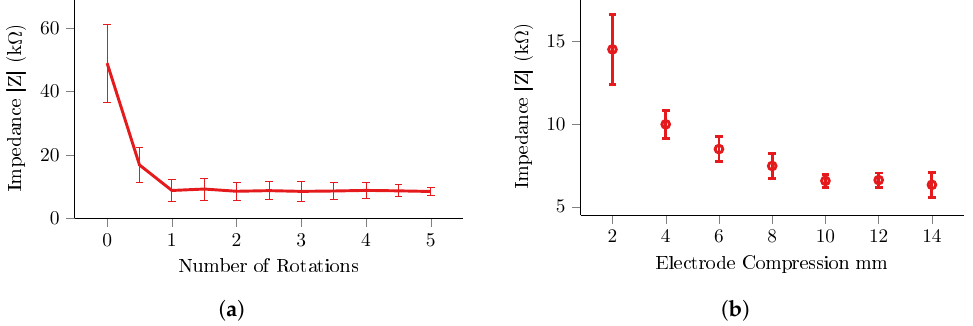
Figure 15. 32 Channel Electrode Helmet ( a ) abrasion results for all electrodes ( b ) minimum impedance achieved across range of